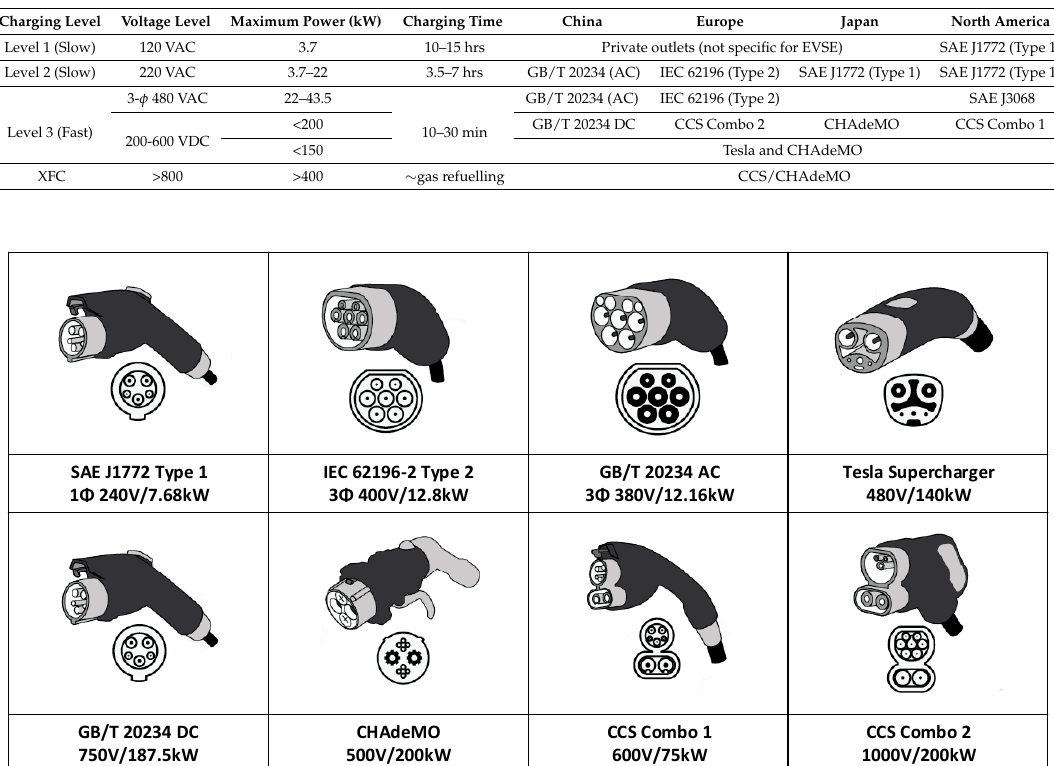
Figure 3. Global male and female battery charger